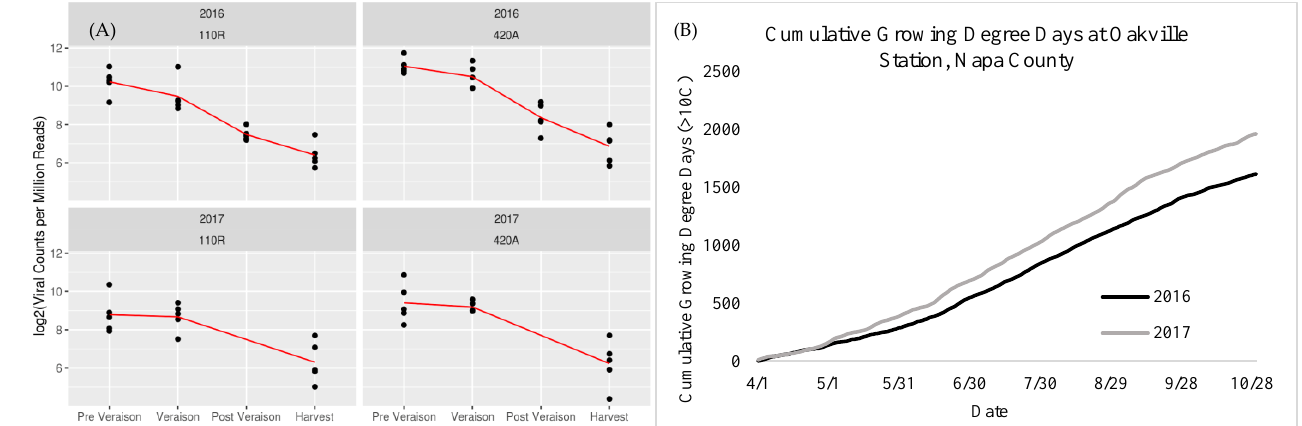
Figure 7. Comparison of viral gene expression in each season ( A ) and cumulative growing degree days in each season ( B ). 110R = Cabernet Sauvignon on 110R rootstock and 420A = Cabernet Sauvignon on 420A rootstock. Viral counts consist of the two mRNAs (sense strand and antisense strands) thought to translate the five proteins encoded by the GRBV genome.